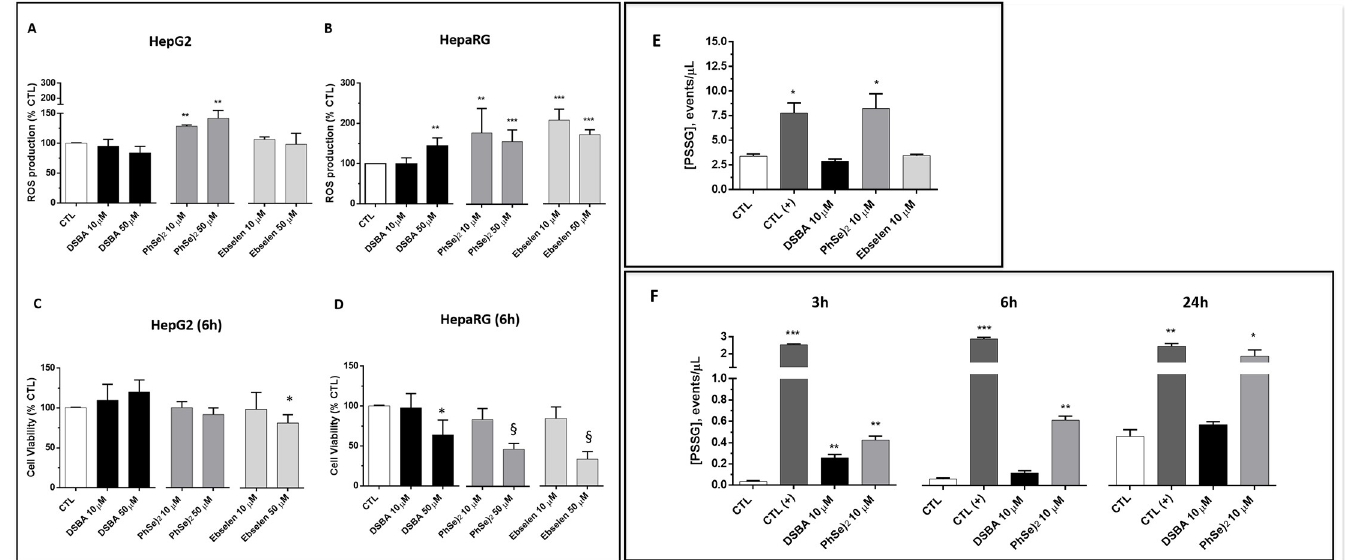
Fig 1. Reactive oxygen species (A and B), cell viability (C and D) protein S-glutathionylation (E and F) in the human liver cell lines HepG2 (A, C and E) and HepaRG (B, D and F). HepaRG or HepG2 cells were treated for 24 hours with 10 μ M DSBA, PhSe) 2 or Ebselen then ROS were measured the DCF method. Protein S- glutathionylation ( PSSG) was assessed in permeabilized cells by FACS-Scan as described in the text. https://doi.org/10.1371/journal.pone.0205626.g001 transiently stimulated PSSG formation in these cells that was again very sensitive to (PhSe) (Fig 1). DSBA was less efficient than Ebselen in decreasing GST activity in the hepatocellular carci- noma cell line HepG2 (Table 1). Conversely, DSBA, but not Ebselen, reduced GST activity lev- els in the non-tumoral cell line HepaRG that expresses lower GST activity than HepG2 cells (Table 1). The absence of a decrease in the GST activity of HepaRG cells during treatment with Ebselen, a potent and irreversible inhibitor of GST [6], could be explained by the gene induc- tion properties of this compound that is demonstrated for the different isoforms of GST [2]. Table 1. Cellular and extracellular levels of glutathione in tumoral HepG2 and non-tumoral HepaRG human liver cell lines treated for 24 hours with DSBA. Intracellular GSH (nmol/10 6 cells)